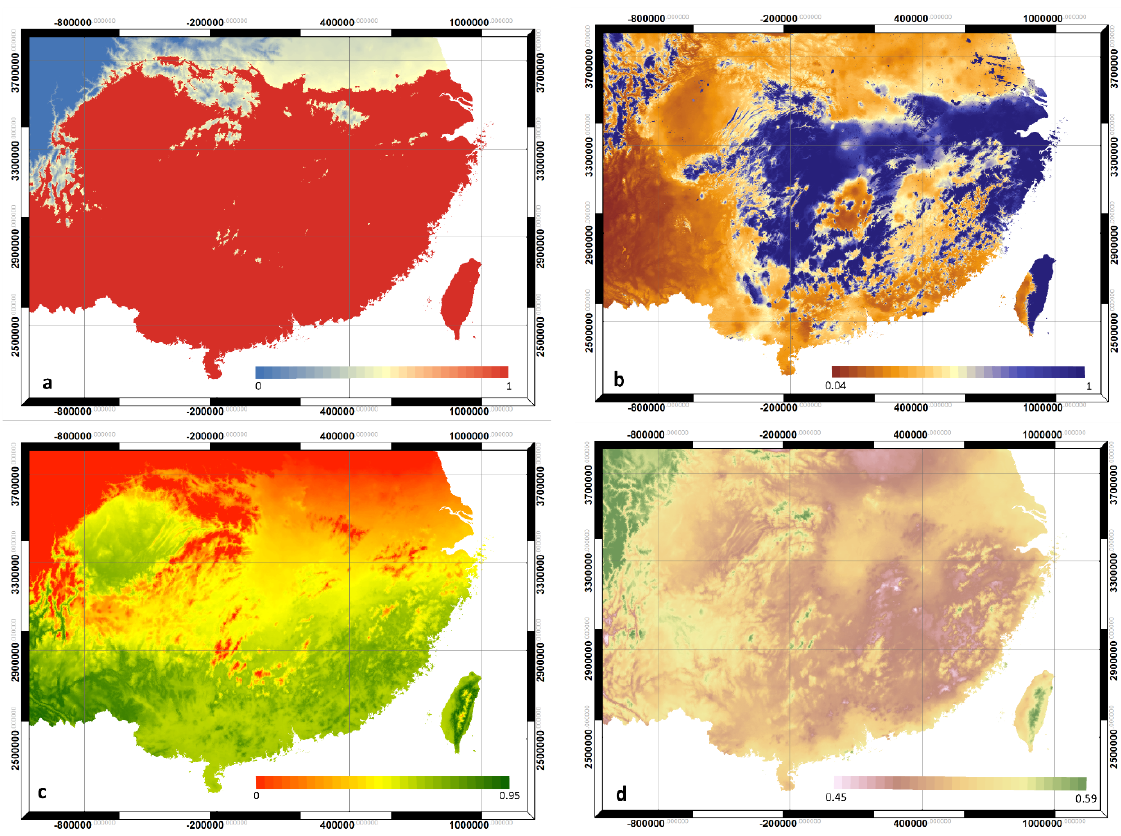
Figure 2. Spatial variation of climatic modifiers produced by the 3-PG model. All modifiers were scaled between zero and one, where one represents the optimum condition for Chinese fir growth and zero indicates growth shutdown for at least one month; ( a ) Frost; ( b ) soil water; ( c ) temperature; ( d ) evaporative demand (VPD).